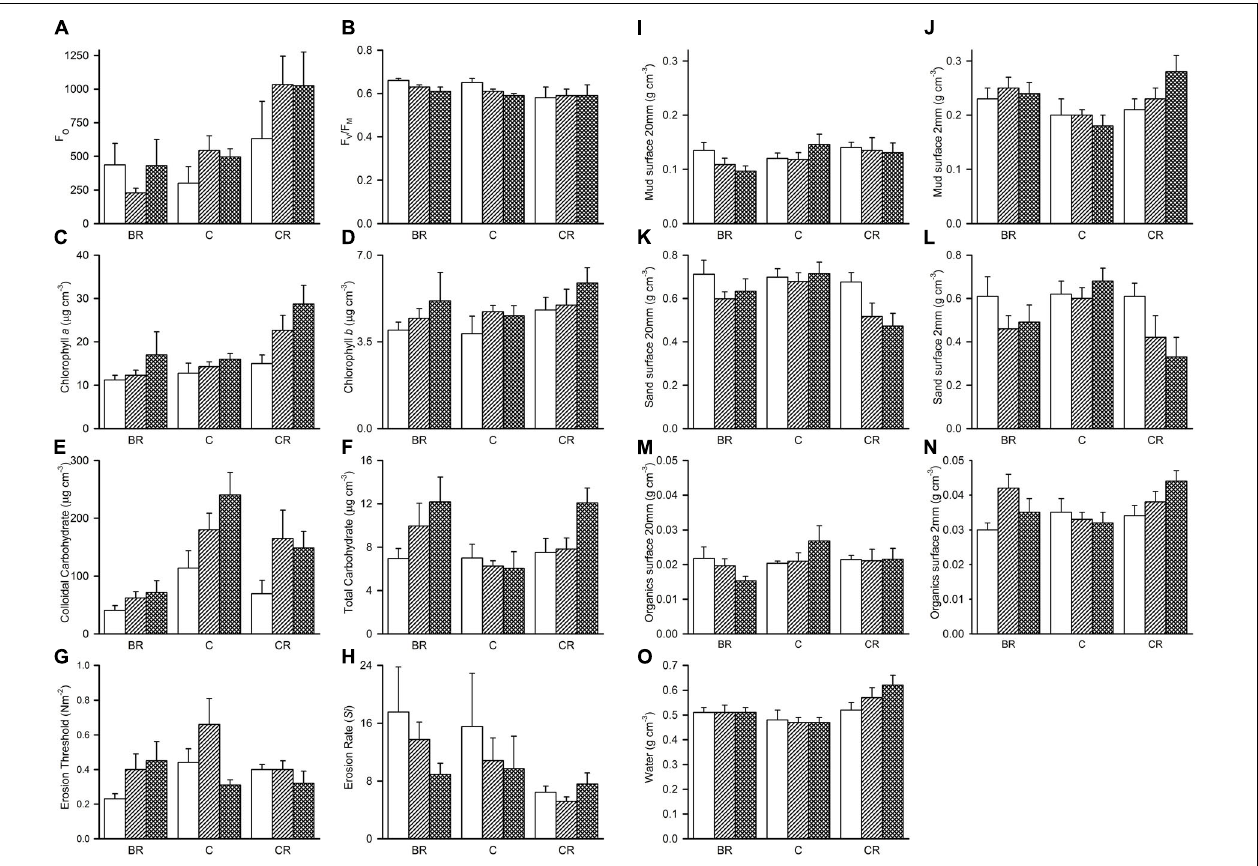
FIGURE 4 | Tambourine Bay properties of sediment after 2 weeks, mean ( SE ; n = 4 plots) in plots with black roofs (BR), clear roofs (CR), or unshaded control plots (C), when provided with added nutrients (white bars), no nutrients (linear hatched bars), or the associated procedural control (crosshatched bars). Panel (A) F o , (B) F v / F m , (C) chlorophyll a , (D) chlorophyll b , (E) colloidal carbohydrates, (F) total carbohydrates, (G) erosion threshold, (H) erosion rate, (I) mud from 20 mm deep core, (J) mud from 2 mm deep core, (K) sand from 20 mm deep core, (L) sand from 2 mm deep core, (M) organics from 20 mm deep core, (N) organics from 2 mm core, and (O) water from 2 mm deep core. F o and F v / F m measured with a PAM (unitless); erodibility measured with a CSM, erosion threshold (N m − 2 ), erosion rate (dimensionless); all other measures are mass density (wt per cm − 3